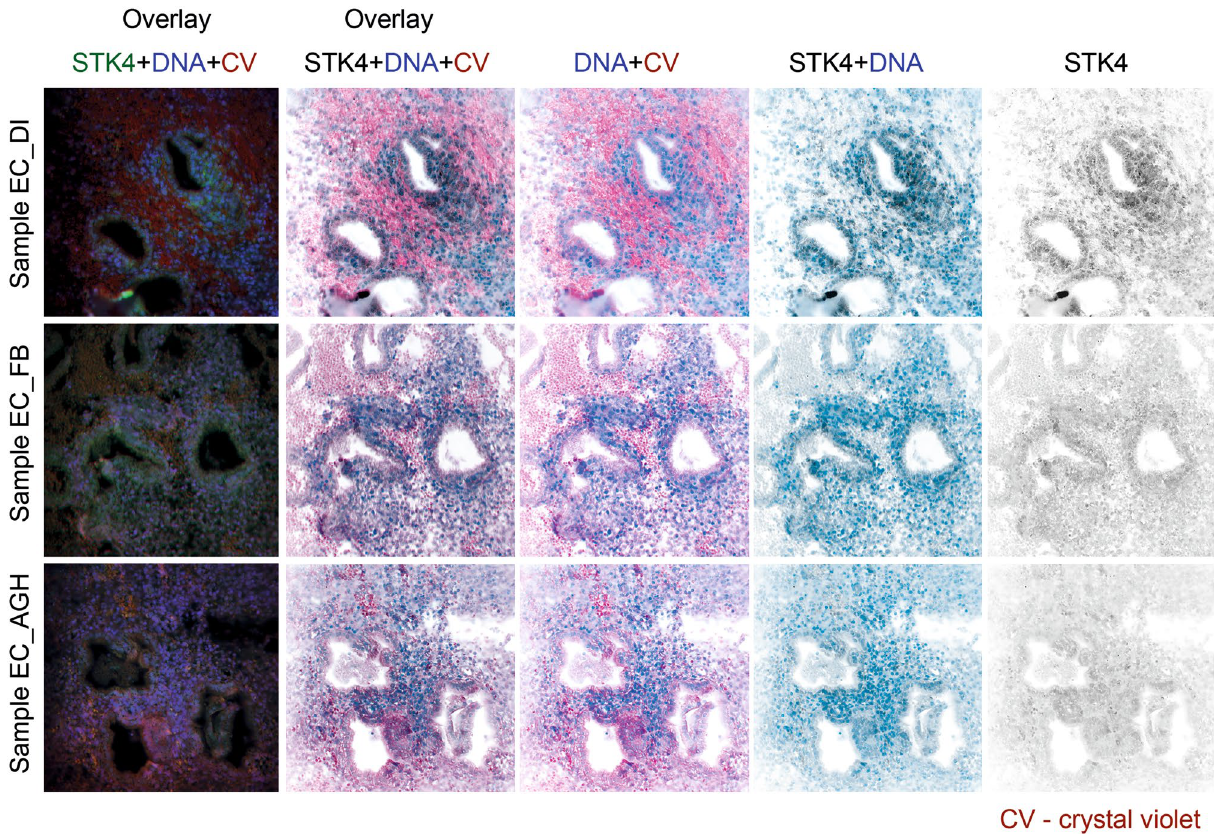
Figure 1. Representative images of the STK4 protein staining in EC tissue. Expression of STK4 was assessed by immunohistochemistry, using a specific antibody. The signal (shown in green and black) was detected mainly in nuclei and in the cytoplasm. Nuclei were counterstained with DAPI. The top row—highly differentiated endometrial carcinoma, the bottom row—middle-low differentiated endometrioid carcinoma. Notice that the STK4 protein signal decreased with tumor progression. CV crystal violet, DNA deoxyribonucleic acid, STK4 serine/threonine-protein kinase